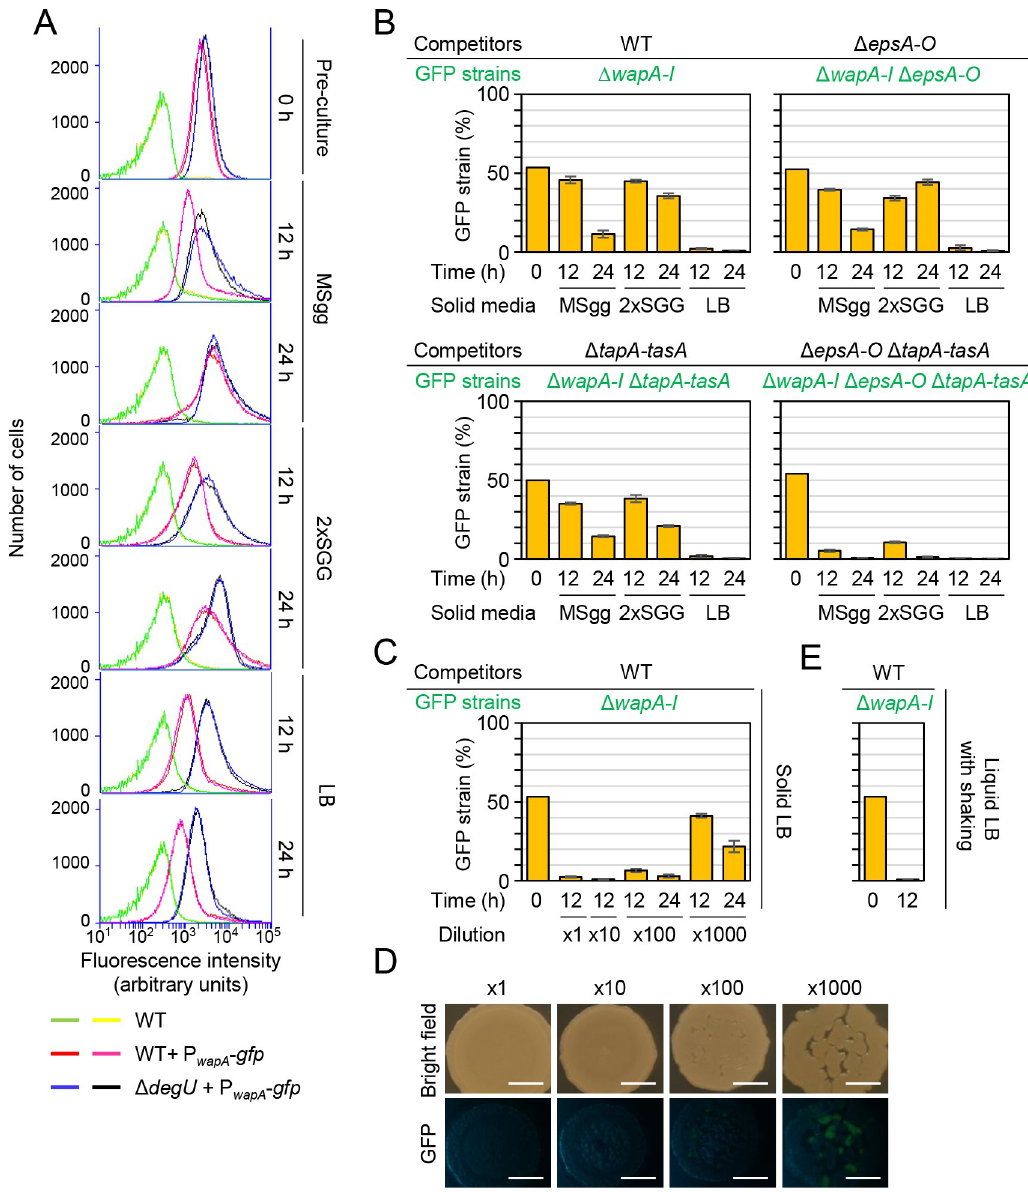
media in different genetic backgrounds. The proportion of GFP-reporter strains within colonies was reported as mean ± standard deviation ( n = 3). (C) Herd protection did not protect against WapA. Competition assays were conducted